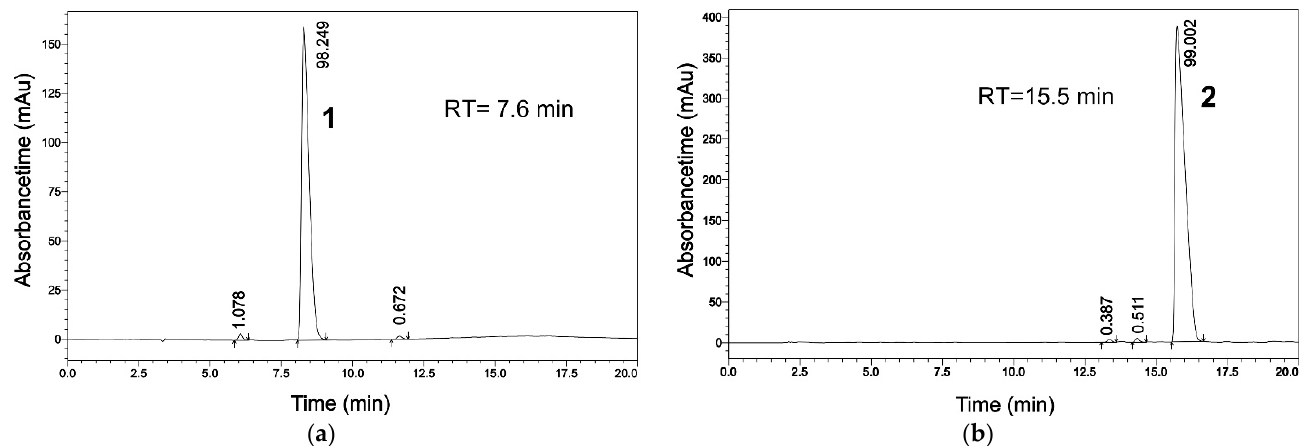
Figure 2. HPLC chromatograms of diastereomers: ( a ) 1 and ( b ) 2 (for HPLC conditions, refer to the SM).